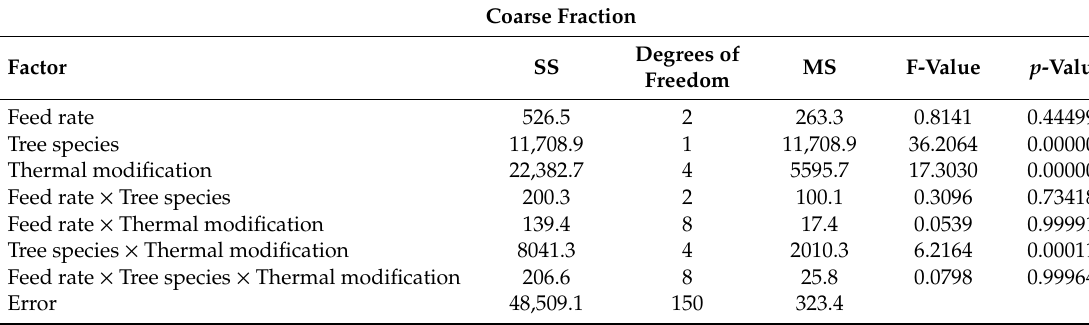
Table 4. Multiple factor analysis of variance in the case of coarse fraction.